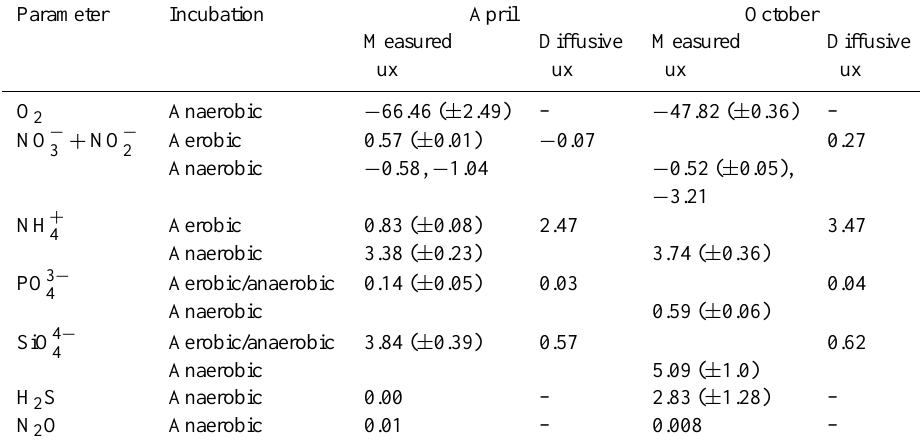
Table 2. Sediment–water flux rates of dissolved oxygen, nutrients, sulfide and nitrous oxide at station G5, off Goa, during April and October. Mean flux rate was calculated from replicate experiments and the standard deviation is expressed in parentheses. Diffusive fluxes of O 2 , H 2 S and N 2 O are not available as their pore water profiles could not be measured. Positive fluxes denote flux into overlying water from sediment and negative fluxes denote flux into the sediment from overlying water. All values are in mmolm − 2 d − 1